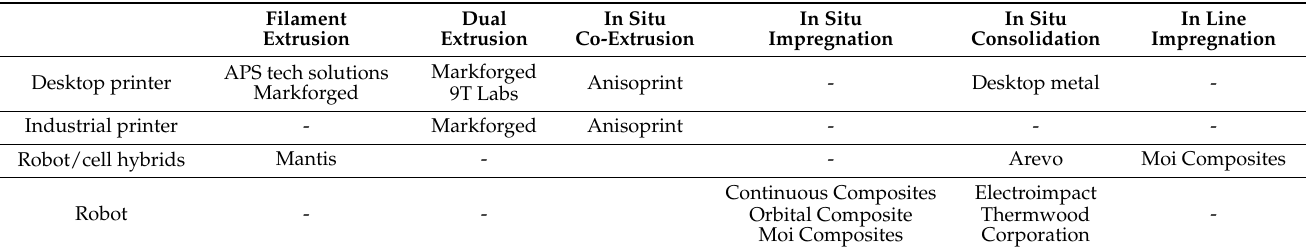
Table 1. Suppliers of commercial FFF adapted to CFRTPC